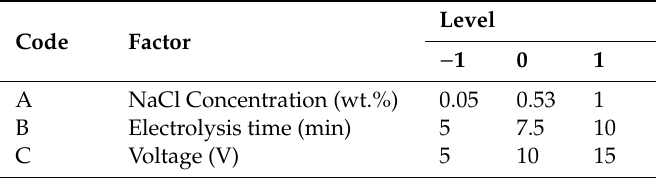
Table 1. Box–Behnken design experiment factors and levels.